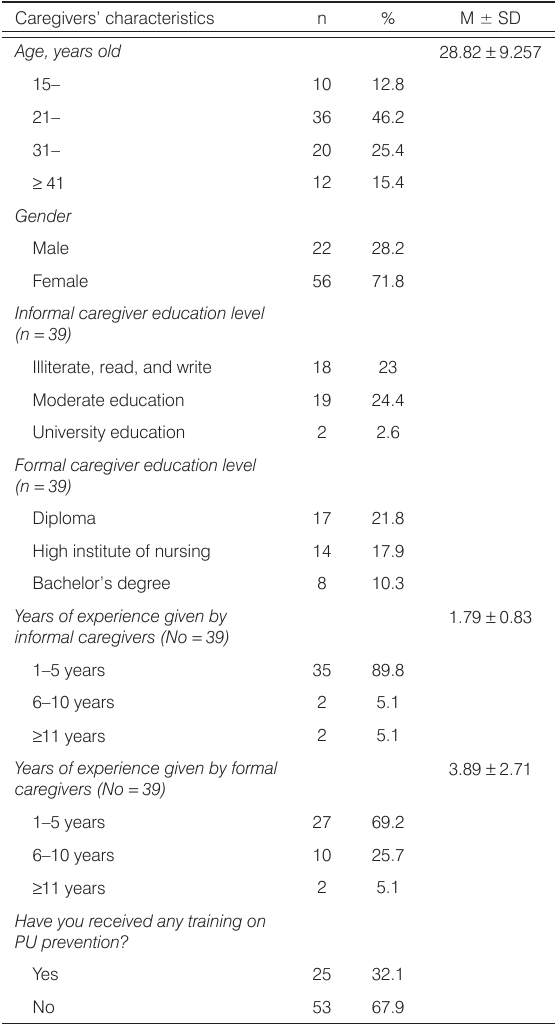
Table 2. Frequency distribution of the elderly caregivers’ demographic characteristic ( n =